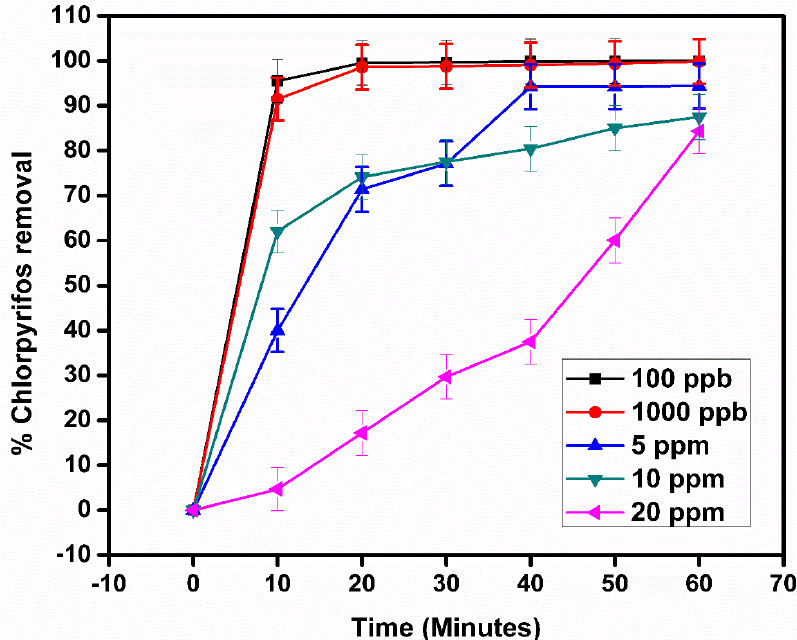
Figure 14. Effect of the initial concentration on the removal of chlorpyrifos (1000 ppb) at pH 7 using 0.1 g of Mn-WO 3 /SnS 2 .